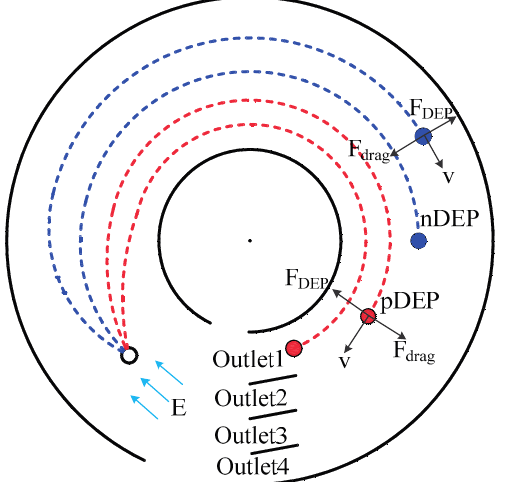
Figure 11. Schematic diagram of iDEP separation in a circular microchannel